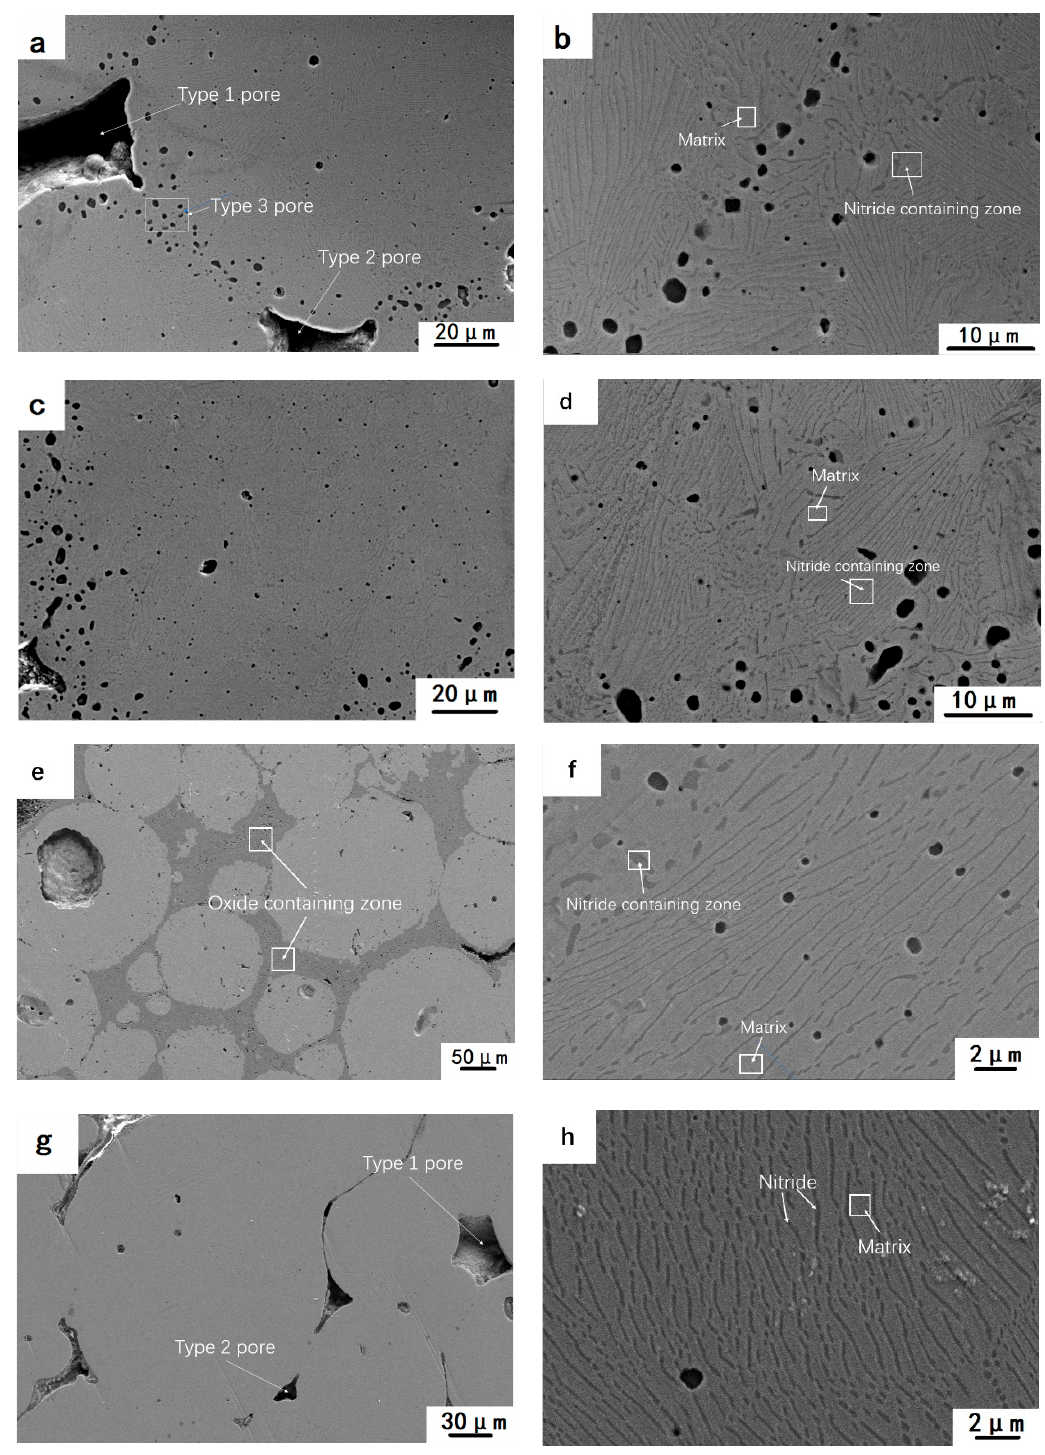
Figure 5. SEM morphology of porous samples reduced by H 2 : ( a , b ): H700; ( c , d ): H1100; ( e , f ): H1200; ( g , h ):H1250.